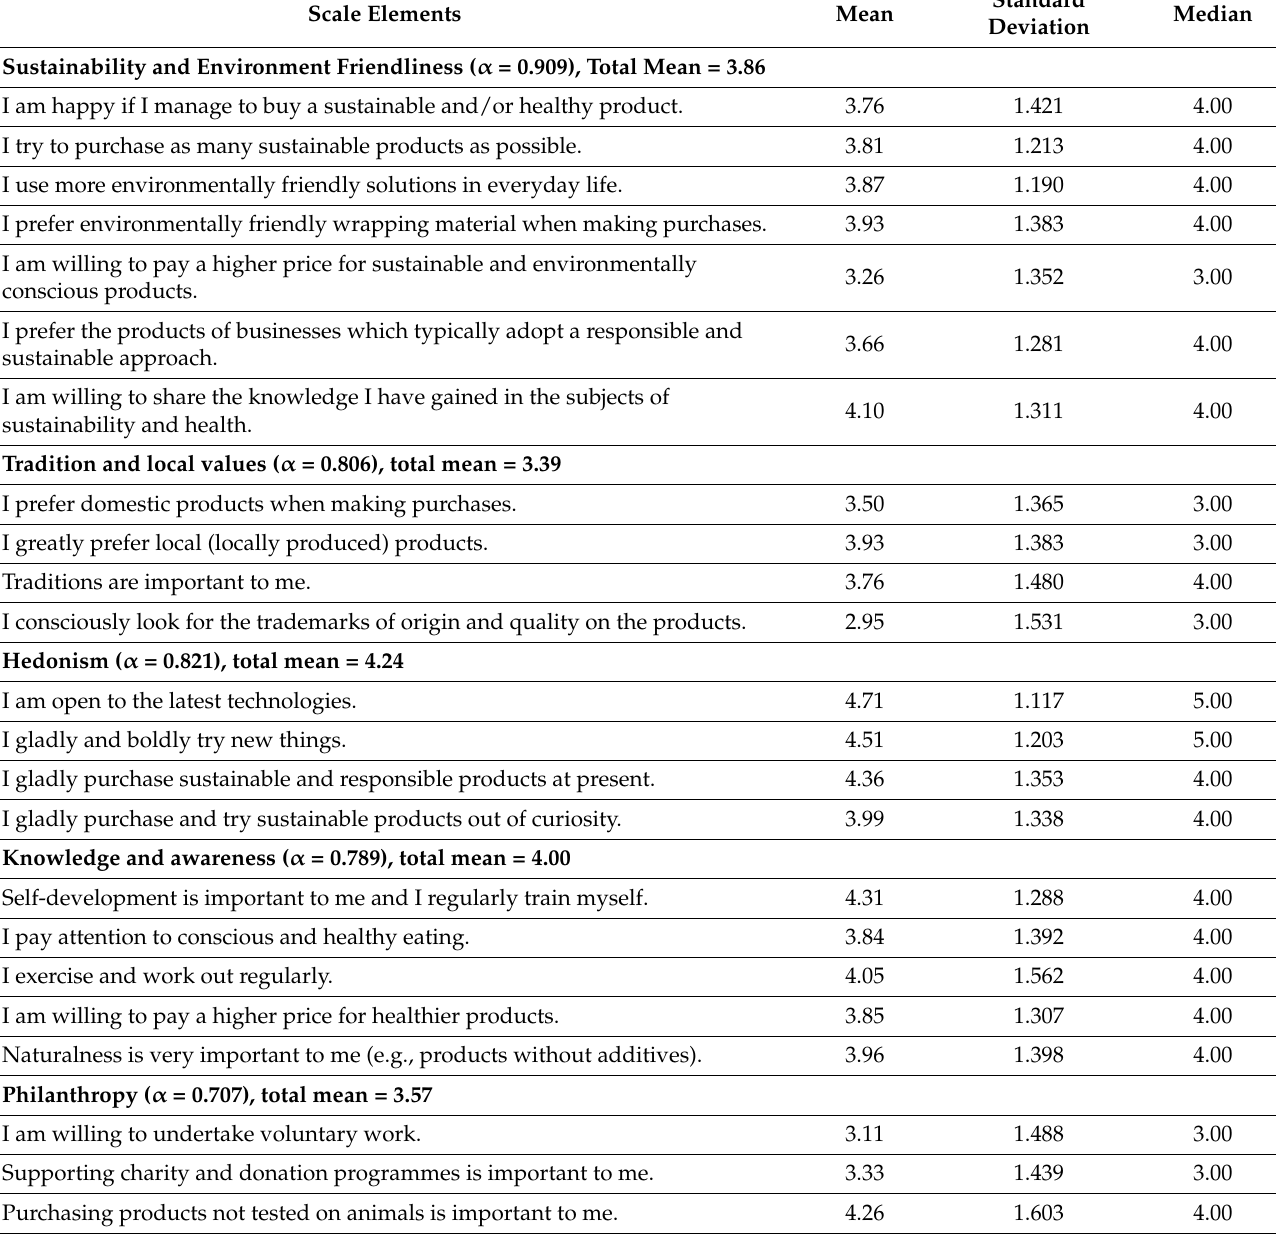
Standard Deviation